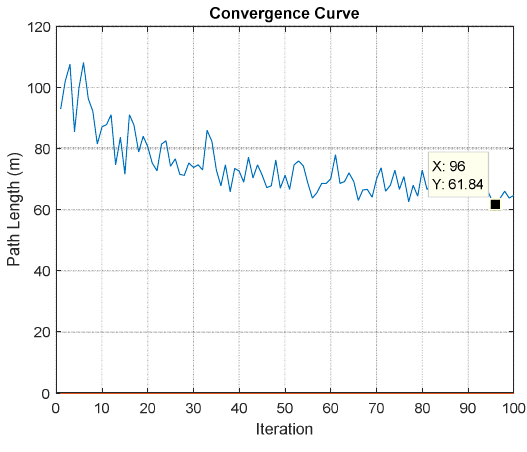
Fig. 25. The Convergence Curve for Experiment 4. From the previous two figure, the mobile robot start avoids static obstacles with the shortest path is (61.8406) in iteration (96) with the total computation time equal to (132.678247).